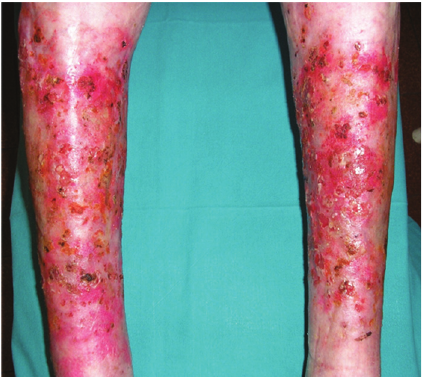
Figure 1: Esulcerative lesions on the legs, with unru ffl ed limits and violaceus borders.